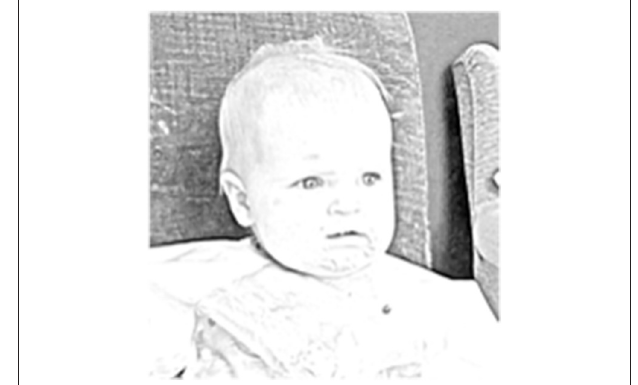
FIGURE 7 | Image published with the written informed consent of the parents of the depicted